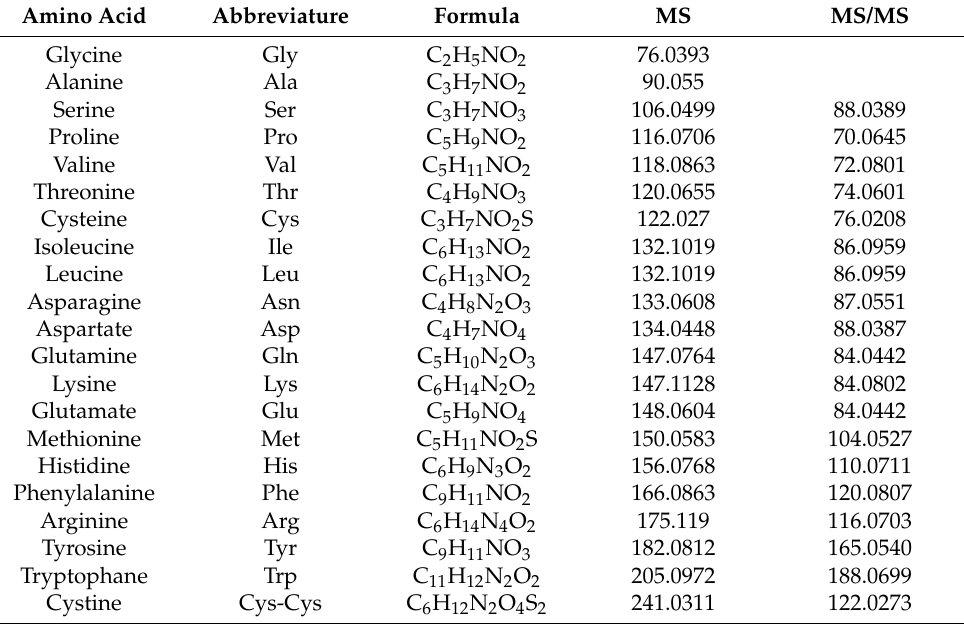
Table 1. Amino acids and molecular formula, molecular mass (MS), and qualifier fragment (MS/MS). Amino